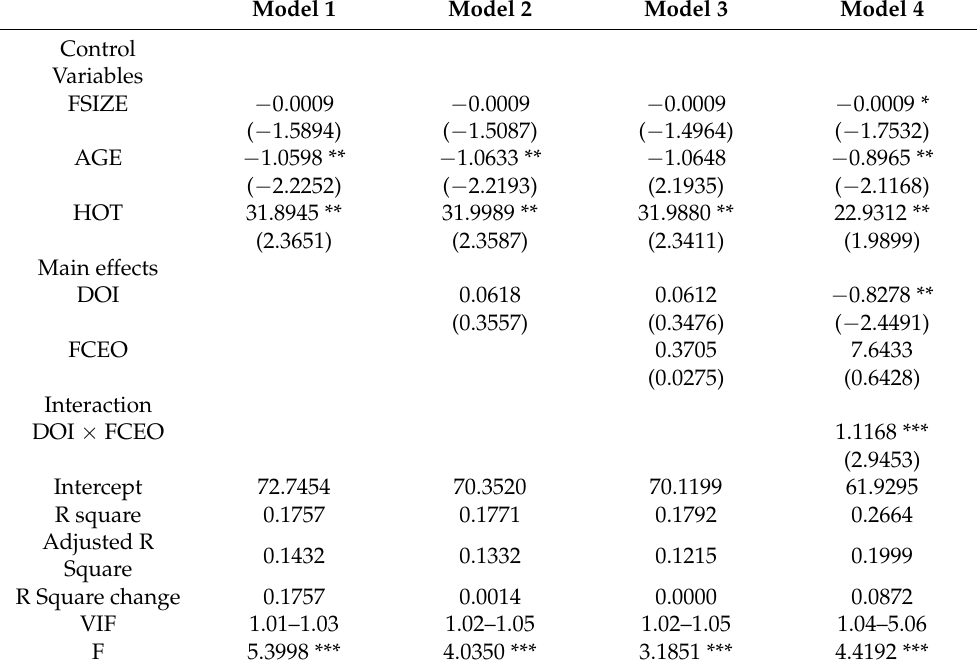
Table 7. Regression analysis